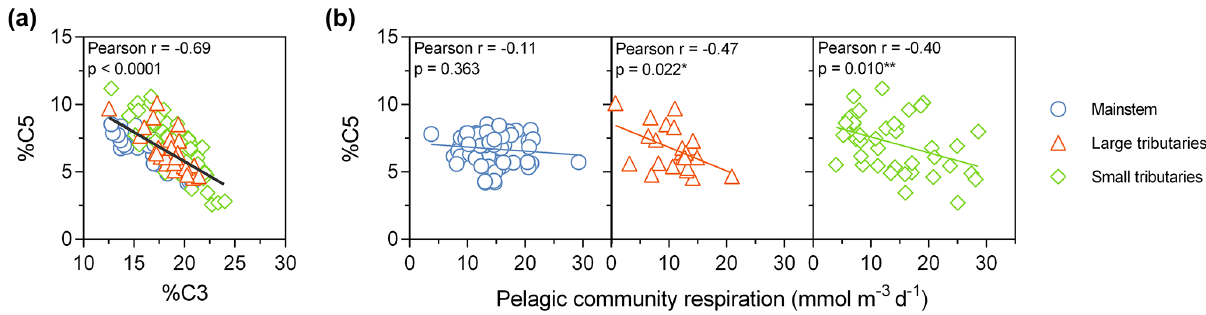
Figure 7. (a) Relationship between %C5 and %C3 and (b) relationships between %C5 and pelagic community respiration ( R ) in the Congo